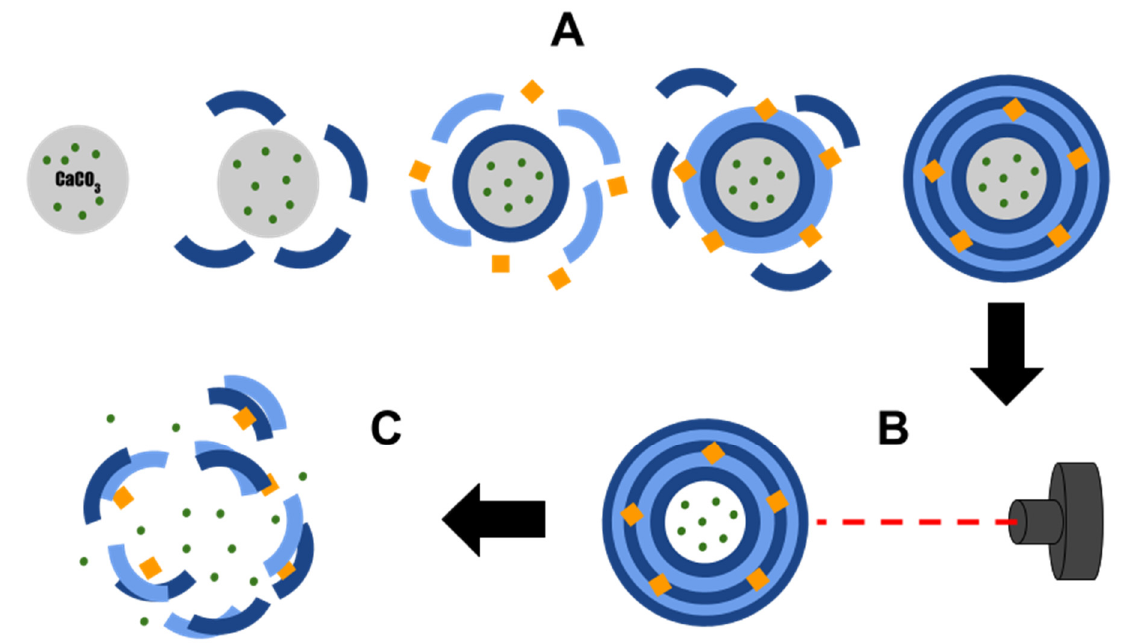
Figure 1. Diagram showing the effect of light on substance release from polyelectrolyte microcap- sules. ( A )—formation of polyelectrolyte microcapsules with metal particles; ( B )—irradiation of microcapsules with light; ( C )—destruction of microcapsules after light irradiation.